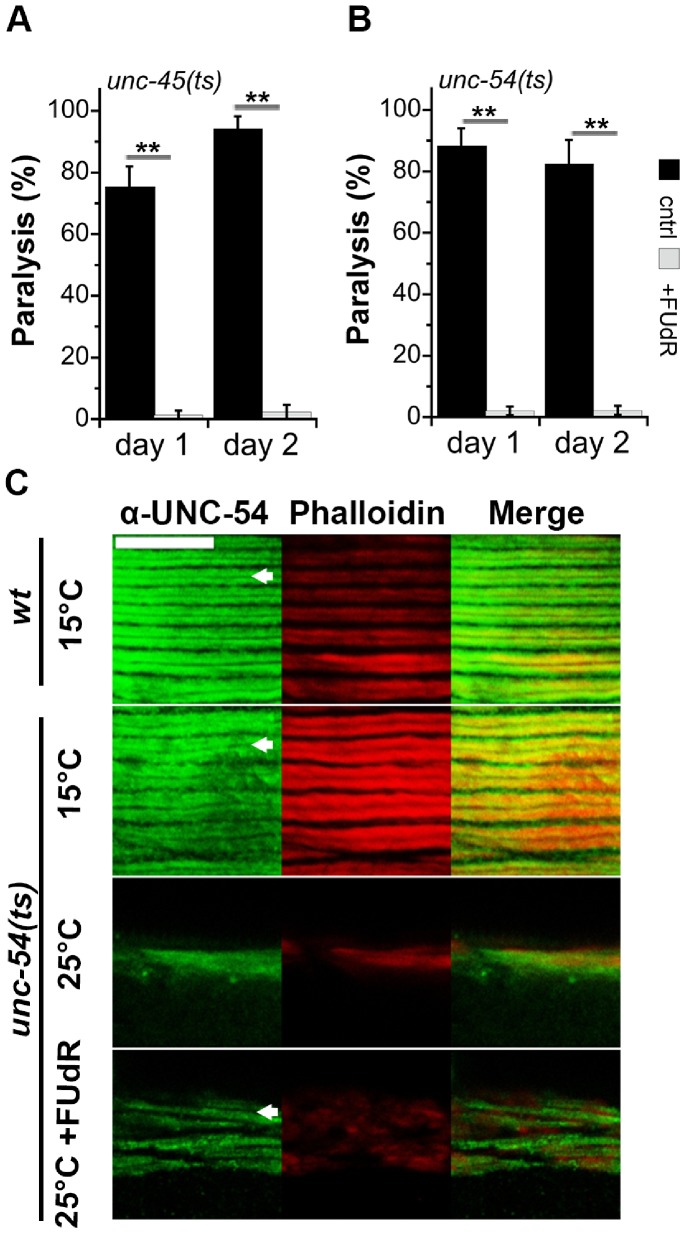
FUdR treatment improved proteostasis before the onset of reproduction.(A–B) The motility of age-synchronized temperature-sensitive unc-45(e286) (A), or unc-54(e1301) (B) animals raised in the absence (black) or presence (gray) of FUdR was examined on the first and second days of adulthood and the percent of paralyzed animals was scored. Data represent means ± SEM of 5 independent experiments. P values compare age-matched treated and untreated animals. (**) P<0.01. (C) Confocal images of age-synchronized unc-54(e1301) animals raised in the absence or presence of FUdR, and stained with anti-UNC-54 antibodies (green) and Phalloidin (red). Arrows indicate myofilaments. Scale bar is 10 µm.